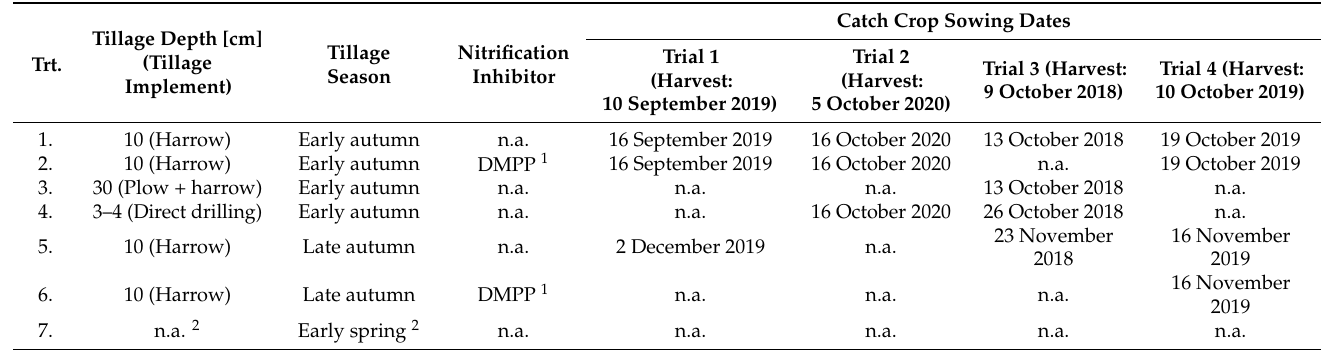
Table 2. Tillage and nitrification inhibitor treatments (trt.) as well as subsequent catch crops sowing (drilling) dates after growing spinach in the